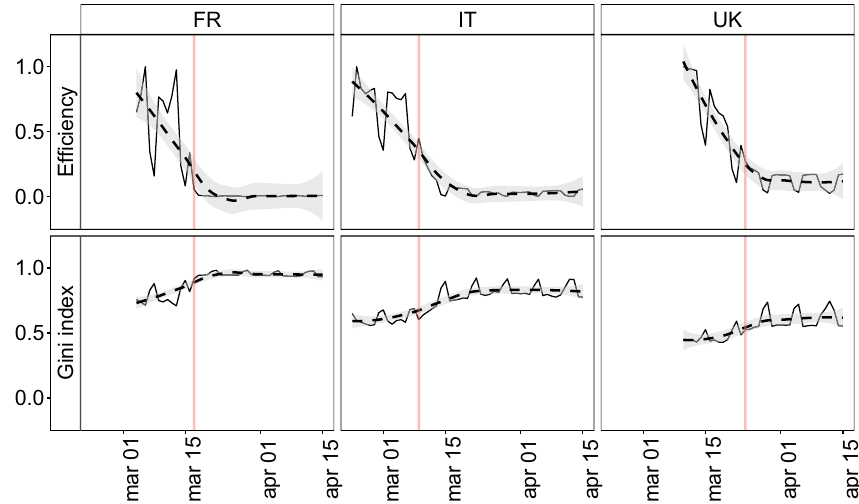
Figure 2. Evolution of global efficiency and of its heterogeneity. Top panels display the temporal evolution of global efficiency (normalized by its maximum value during the period of observation), for the mobility network of municipalities. We visualize trends using a LOESS regression (dashed lines with 95% confidence intervals shaded in grey) and highlight lockdown dates using a solid vertical line. Bottom panels display the temporal evolution of the Gini index of the nodal efficiency. The Gini index is used as a measure of heterogeneity and it is computed considering the nodal contributions to global network efficiency. Overall, we observe an increase of the Gini index indicating an increasing heterogeneity over